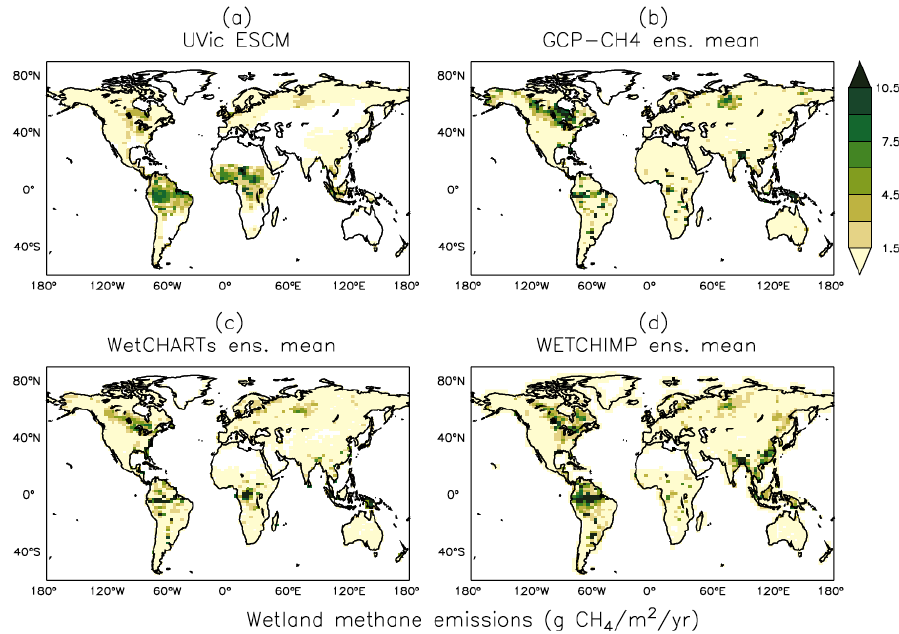
Figure 10. Average methane emissions from global wetlands over the 2001–2004 period as simulated by the UVic ESCM (a) in comparison to three process-based model ensembles: (b) GCP-CH4, (c) WetCHARTs, and (d) WETCHIMP. The model ensembles are regridded to 3.6 ◦ × 1.8 ◦ for a fair comparison with the UVic ESCM. The comparison period corresponds to the overlap period for the three model